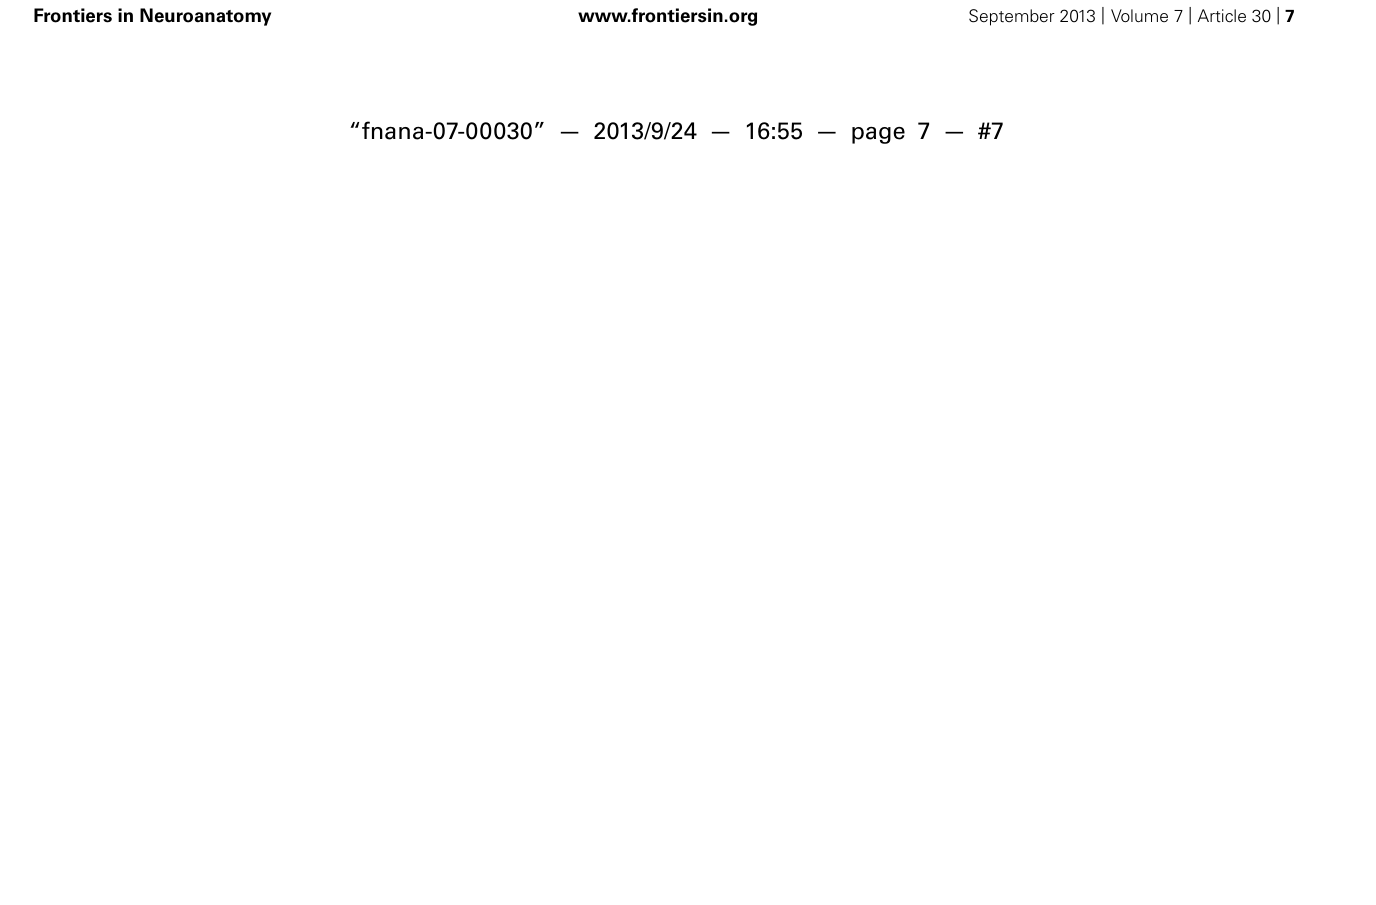
FIGURE 6 |The number of NF + , but not CR + , dystrophic neurites (DN) was significantly related toA β plaque size in both preclinical (A, ** p < 0.001, t -test) and end-stageAD (B, ** p < 0.001), as well as in APP/PS1 (C, ** p < 0.001) andTg2576 (D, * p < 0.01, t -test) transgenic